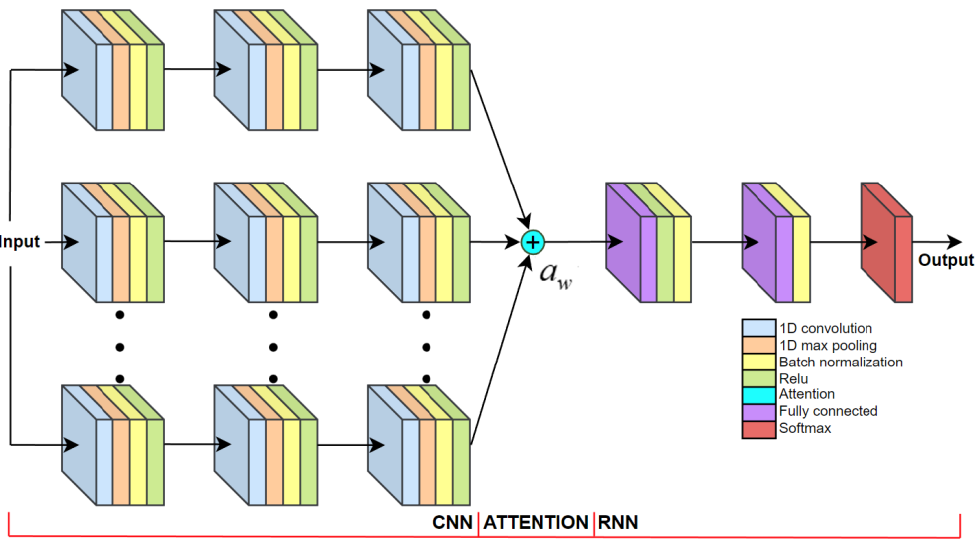
Figure 9. Visualization of the CNNA + RNN algorithm architecture.